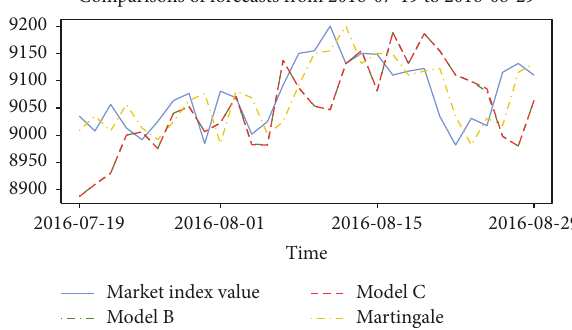
Figure 15: Time plots of raw data and the forecasts of model B.